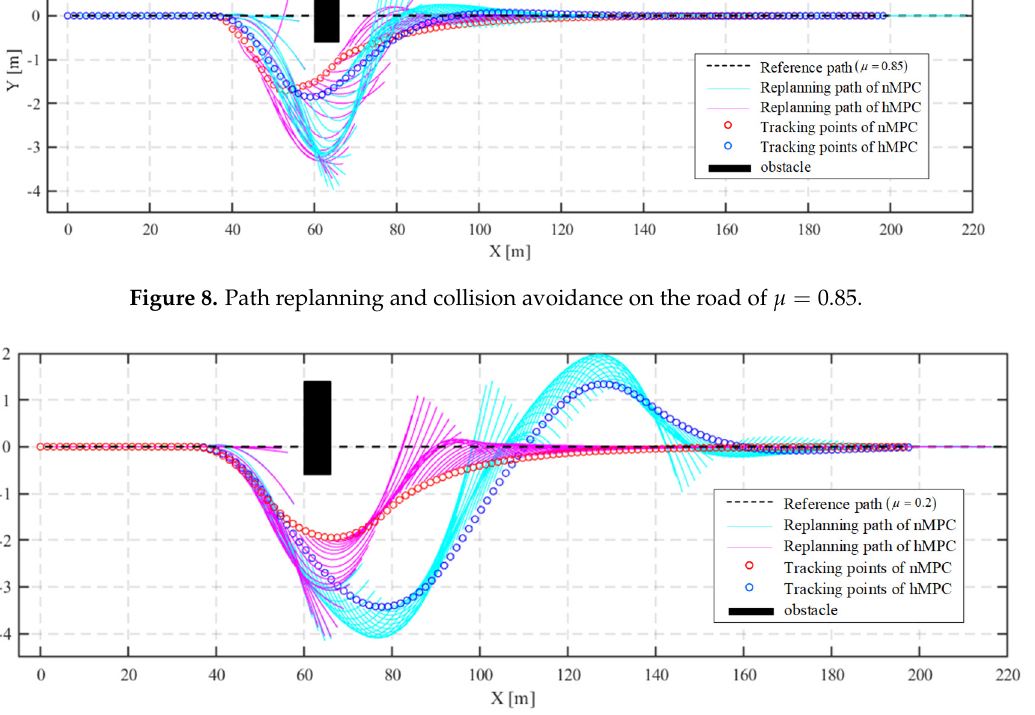
Figure 9. Path replanning and collision avoidance on the road of µ = 0.2. Table 3. Comparison of tracking errors and computing time of two methods. Path Tracking